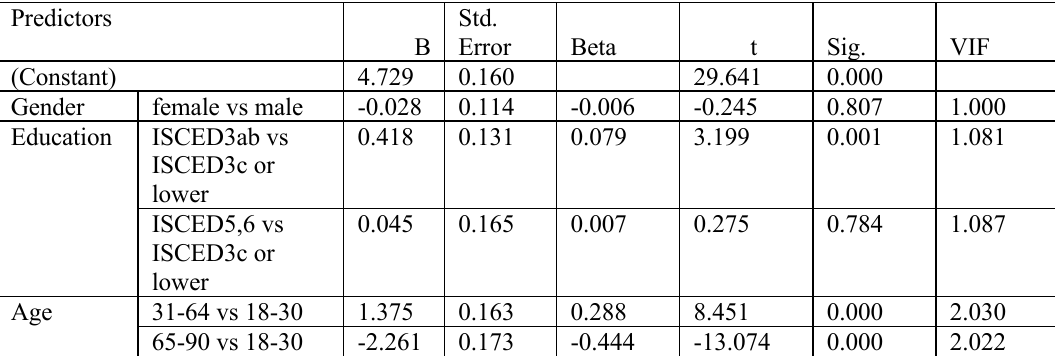
Table 3: A model for intrinsic motivation not to participate Predictors